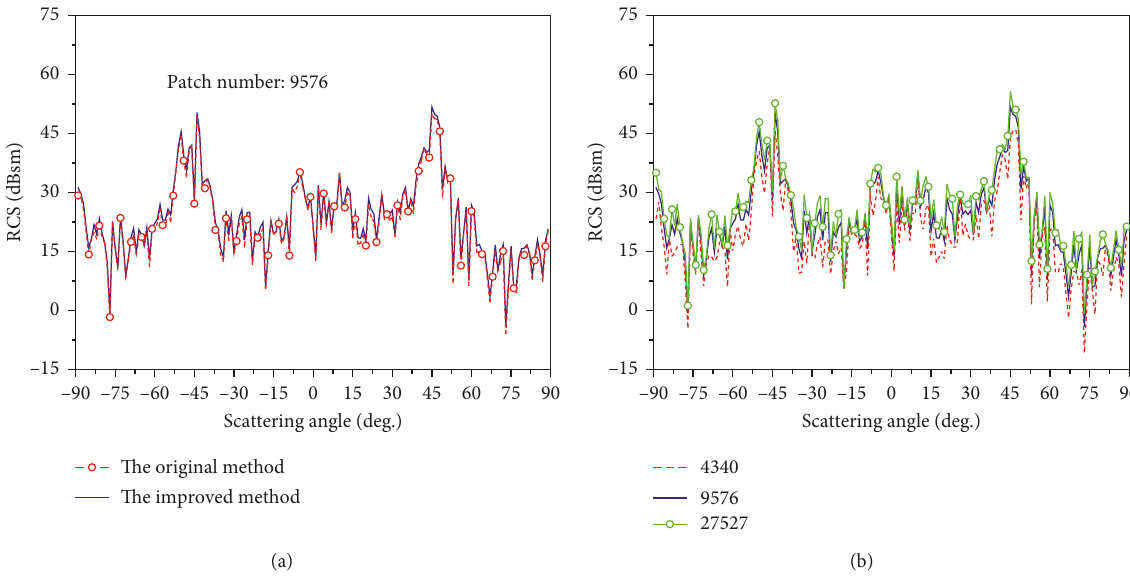
Figure 8: The bistatic RCS of the pure ship target. (a) With different methods. (b) With different number of patches. Table 1: Calculation time of the scattering of the pure ship for the different methods. Calculation time (sec.) The number of patches on ship